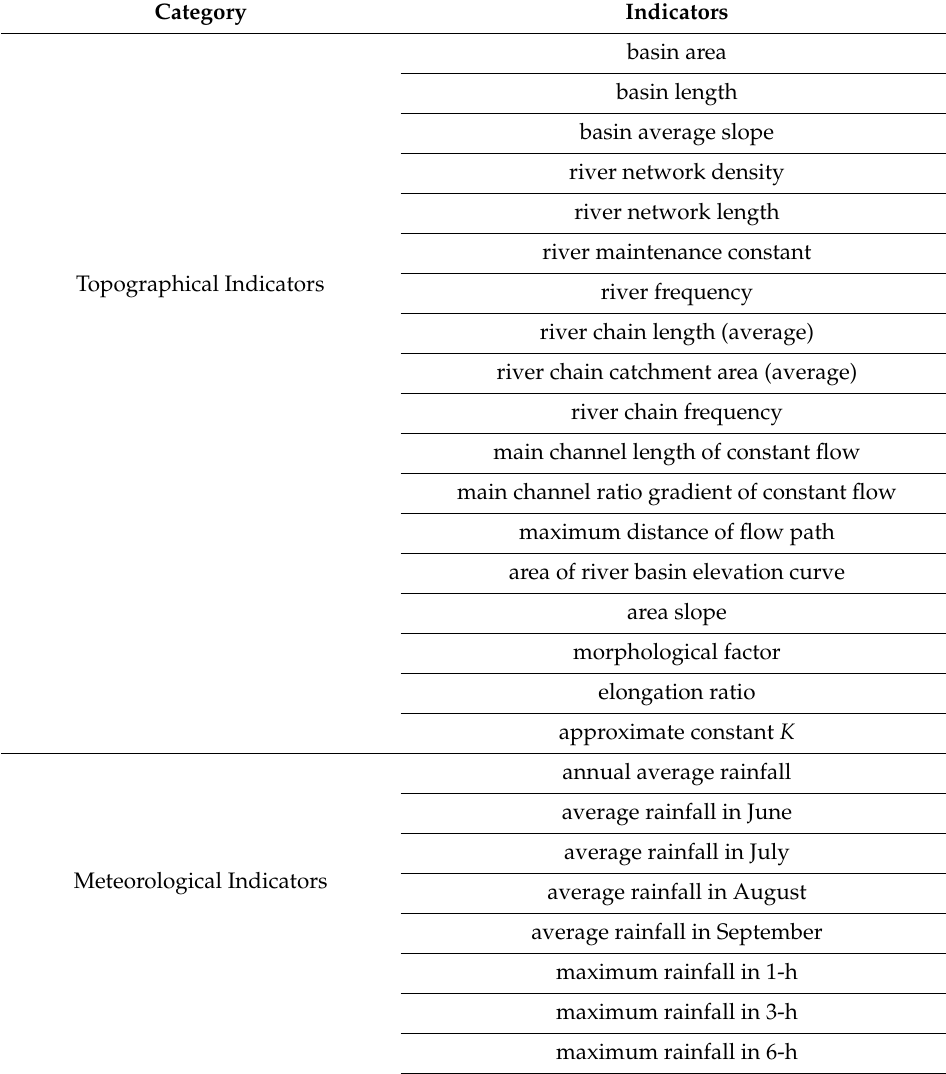
Table 1. 27 hydrological similarity assessment indicators.